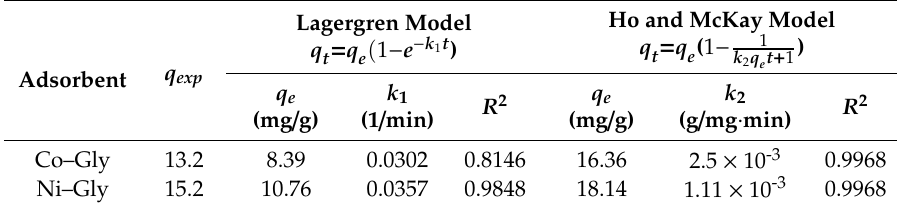
Figure 5. Equilibrium of Cd(II) adsorption onto: a) Co–Gly and b) Ni–Gly.